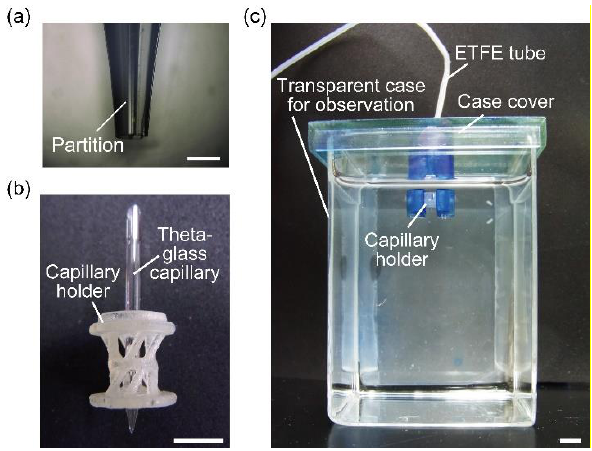
Figure 2. Experimental setups for alginate microfiber formation: ( a ) sharpened theta-glass capillary; ( b ) capillary holder assembled with the sharpened theta-glass capillary; ( c ) experimental setup for formation of alginate microfibers. Scale bars are: ( a ) 200 µm and ( b , c ) 5 mm.